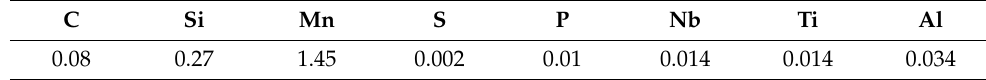
Table 2. Chemical composition of E36 steel (wt %). C Si Mn S P Nb Ti Al 0.08 0.27 1.45 0.002 0.01 0.014 0.014 0.034